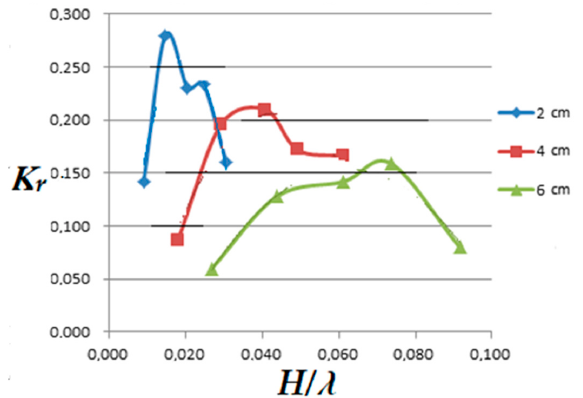
Figure 7. The ratio between the steepness of the incoming wave and the reflection coefficients of the latex plate at a wave height of 2 cm, 4 cm and 6 cm, water depth a = 0.3 m. The graph shows that at different wave heights, the reflection coefficient has 1–2 peaks in the middle. The trend line is closer to the quadratic curve. It is speculated that this phenomenon is wave reflections caused by its components have different characteristics.